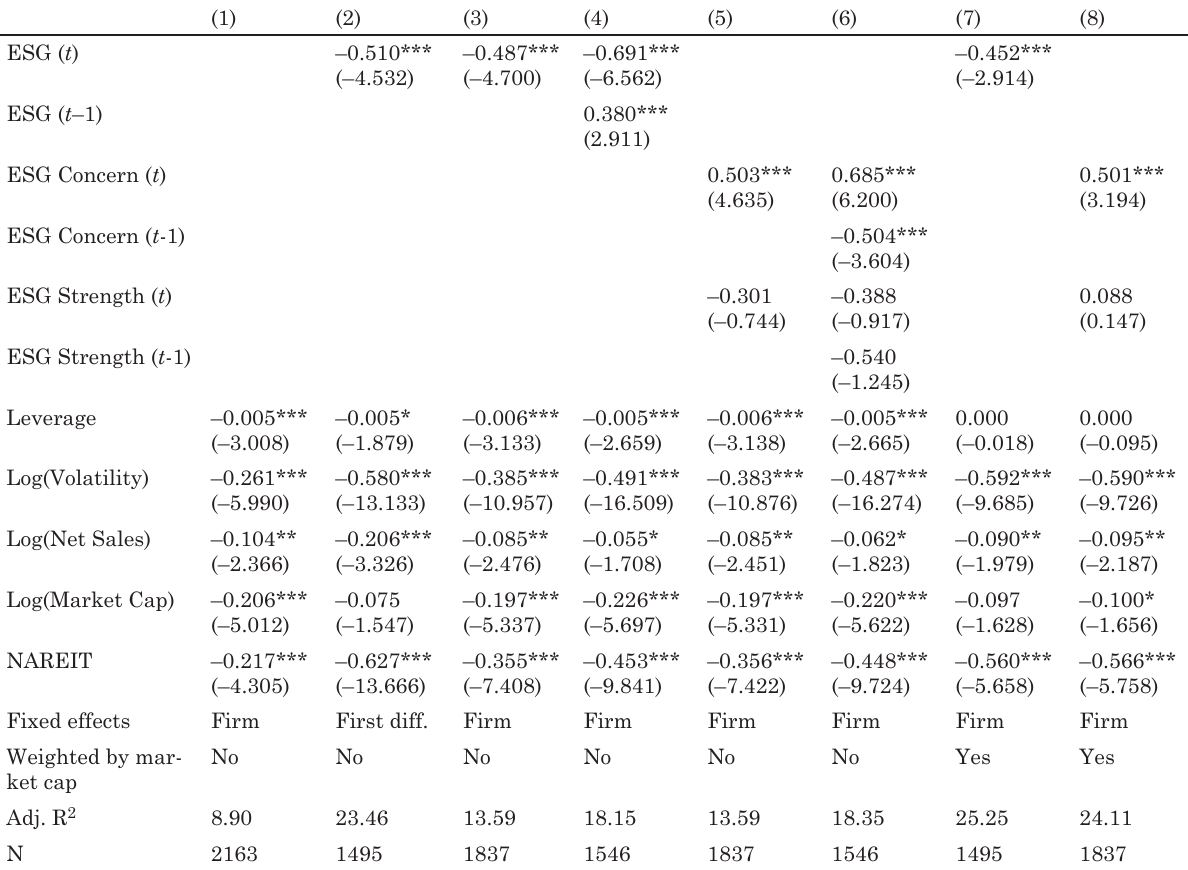
Table 6. Panel fixed effects regression results. Dependent variable: Total